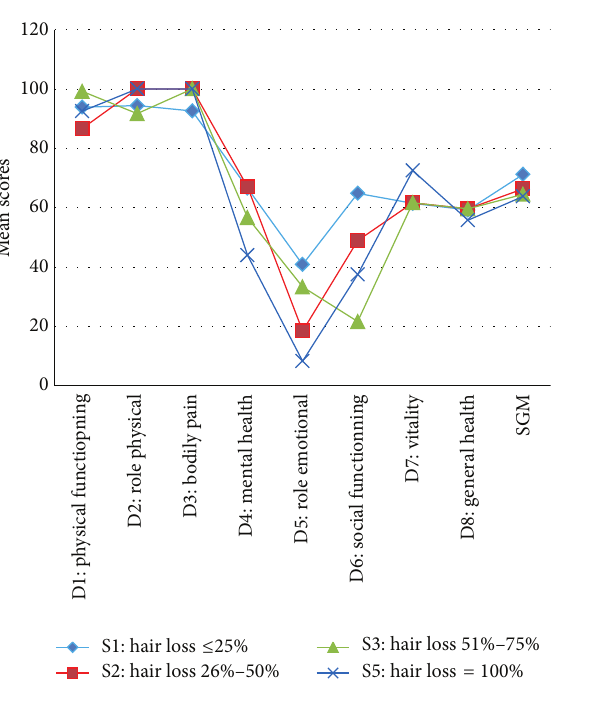
Figure 1: Mean scores SF-36 depending on the severity